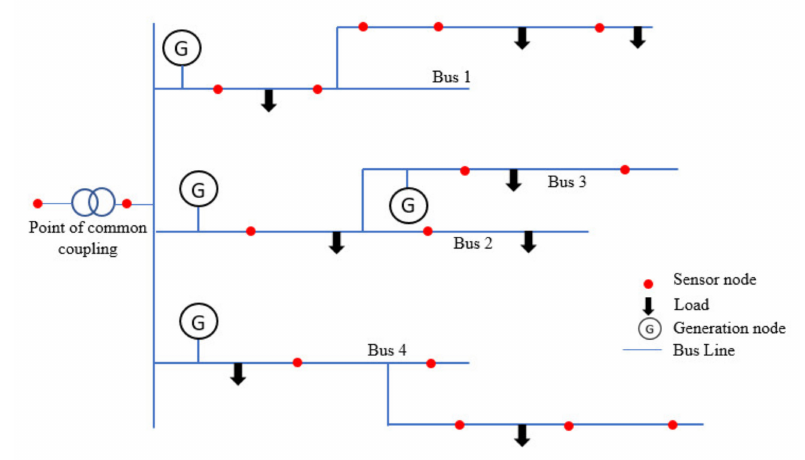
Figure 3. A microgrid physical bus system